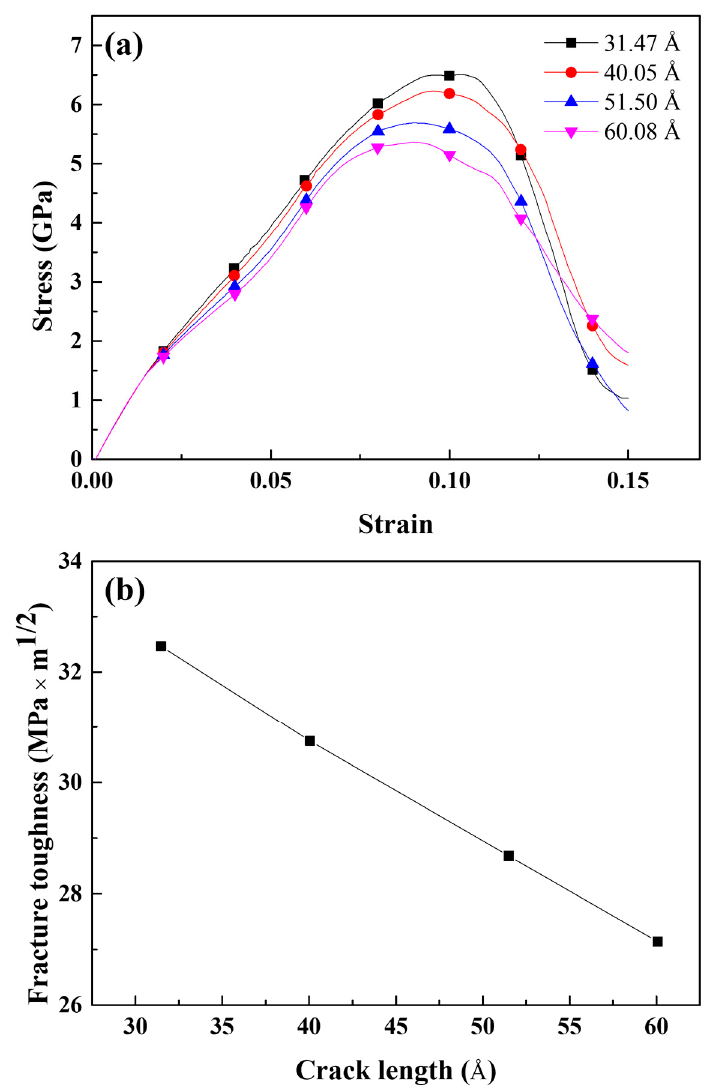
Figure 14. ( a ) Tensile stress–strain curves and ( b ) fracture toughness of the cracked Al containing 4 Å Mg–Si clusters with various thicknesses.